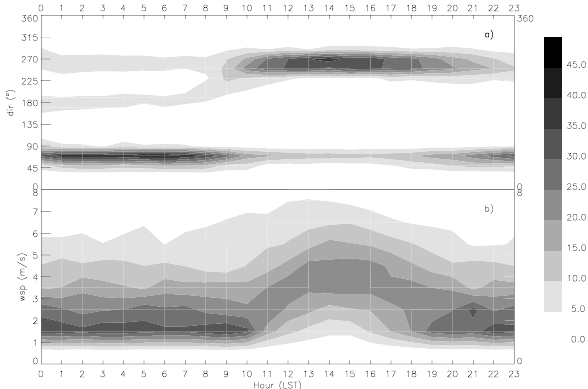
Figure 3. (a) Frequency of wind direction as a function of day hours recorded at the Lamezia Terme surface station for 2007–2008. Grey shading shows the frequency of occurrence (%). (b) as in (a) but for the wind speed. LST = UTC +